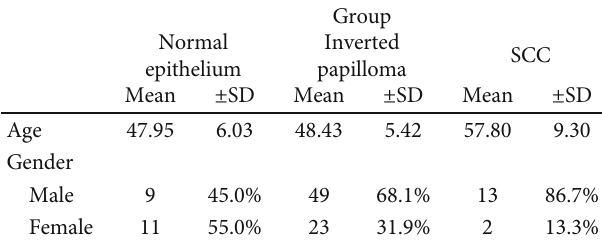
Table 1: Description of age and gender among the studied groups.